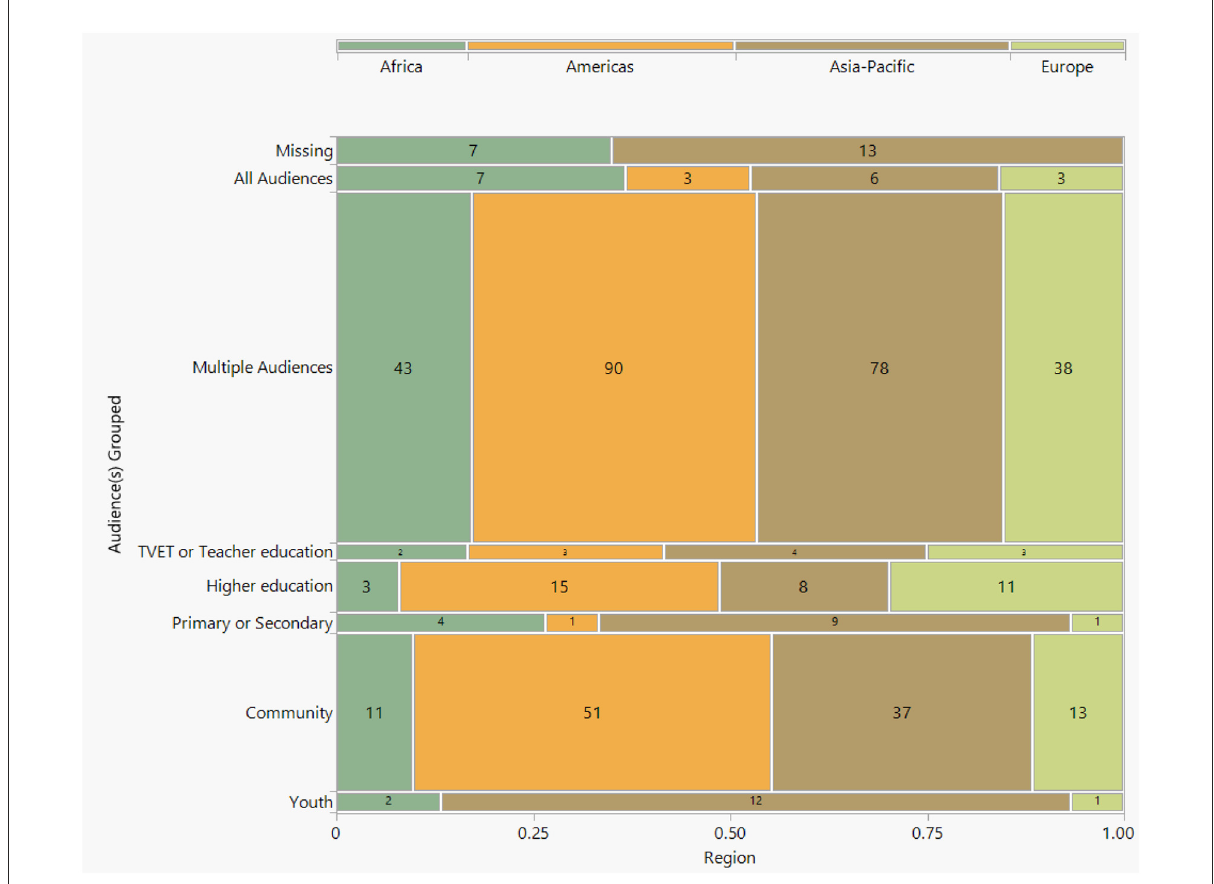
FIGURE7 Audience by